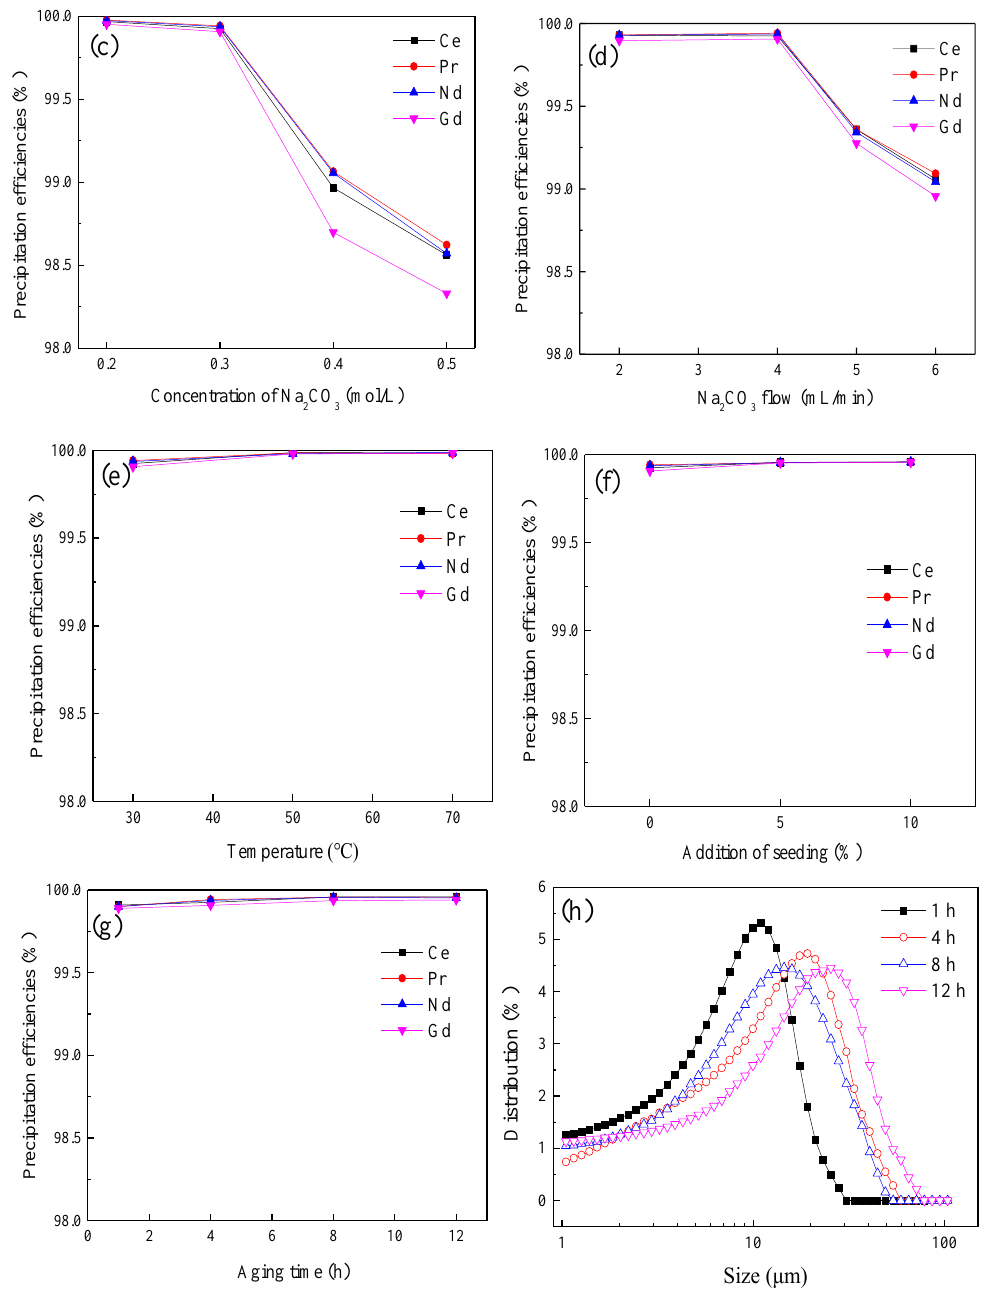
Figure 9. Effects of different factors on the precipitation efficiencies of Ce, Pr, Nd, and Gd. ( a ) Feed- ing method of Na 2 CO 3 ; ( b ) Na 2 CO 3 amount ( n (RE 3+ )/ n (Na 2 CO 3 )); ( c ) Na 2 CO 3 concentration; ( d ) feed liquid flow; ( e ) reaction temperature; ( f ) addition of seed crystals; ( g ) aging time; ( h ) effect of aging time on the size distribution.